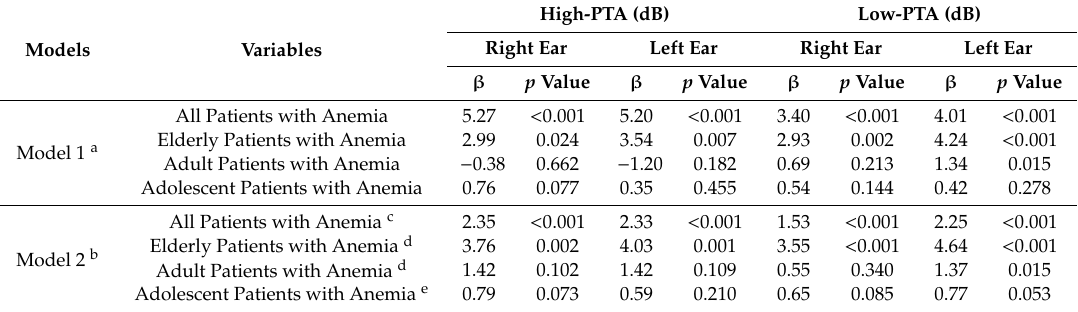
Table 4. Regression analyses of relationships between pure tone average and anemia according to di ff erent age